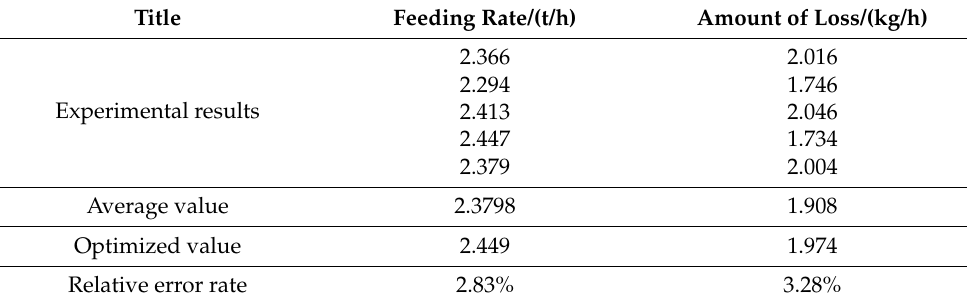
Table 6. Experimental results with optimized parameters.